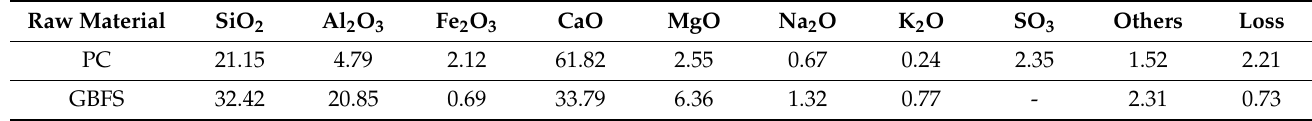
Table 1. Chemical composition of Portland cement %.